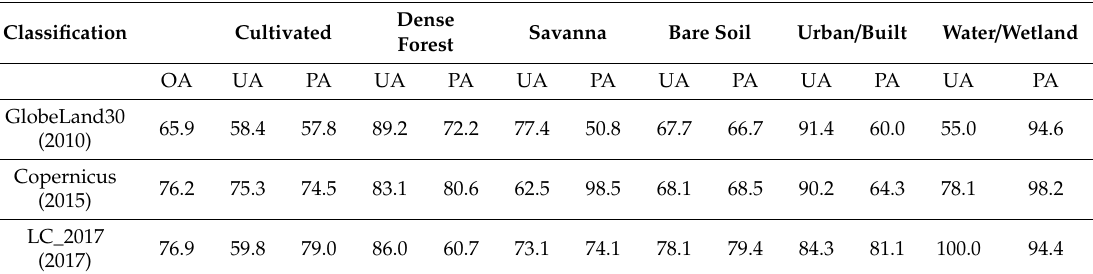
Figure 3. Comparison of the three different land-cover products: ( A ) GlobeLand30 for 2010 at 30 m resolution (the straight lines are due to missing data), ( B ) Copernicus 2015 Land-Cover Product at 100 m resolution, and ( C ) LC_2017 product for 2017 at 30 m resolution. Table 3. Classification accuracy information for the three di ff erent land cover products: GlobeLand30 for 2010 at 30 m resolution, Copernicus 2015 Land Cover Product at 100 m resolution (resampled to 30 m), and our newly developed land cover product for 2017 at 30 m resolution.